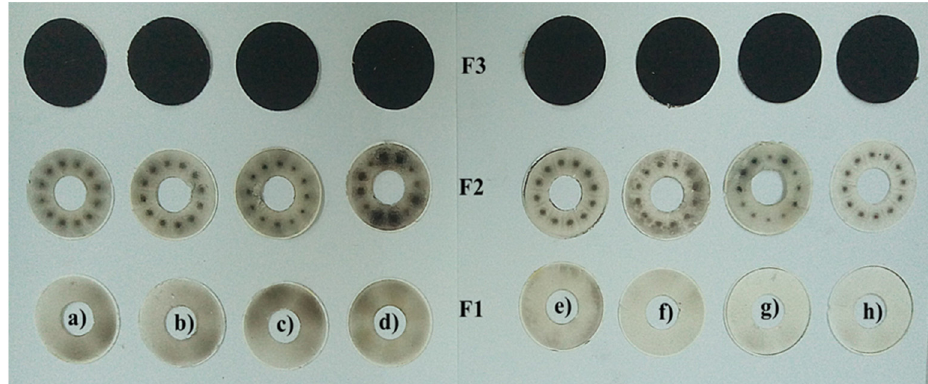
Figure 4. The individual collecting filters: ( a – d ) filters for measurements 1–4 without the use of the ESP; ( e – h ) filters for measurements 1–4 with the use of the ESP.